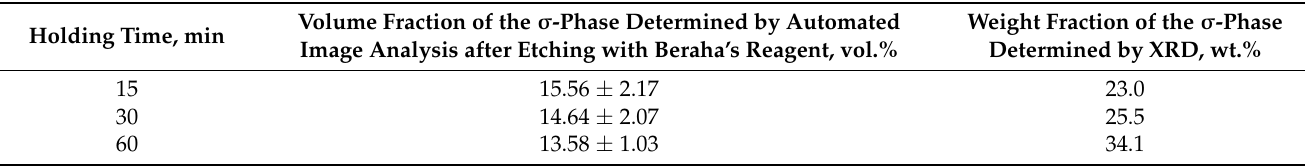
Table 5. The results of evaluating the amount of the σ -phase in specimens of Steel 4 after provoke annealing at 850 °C.